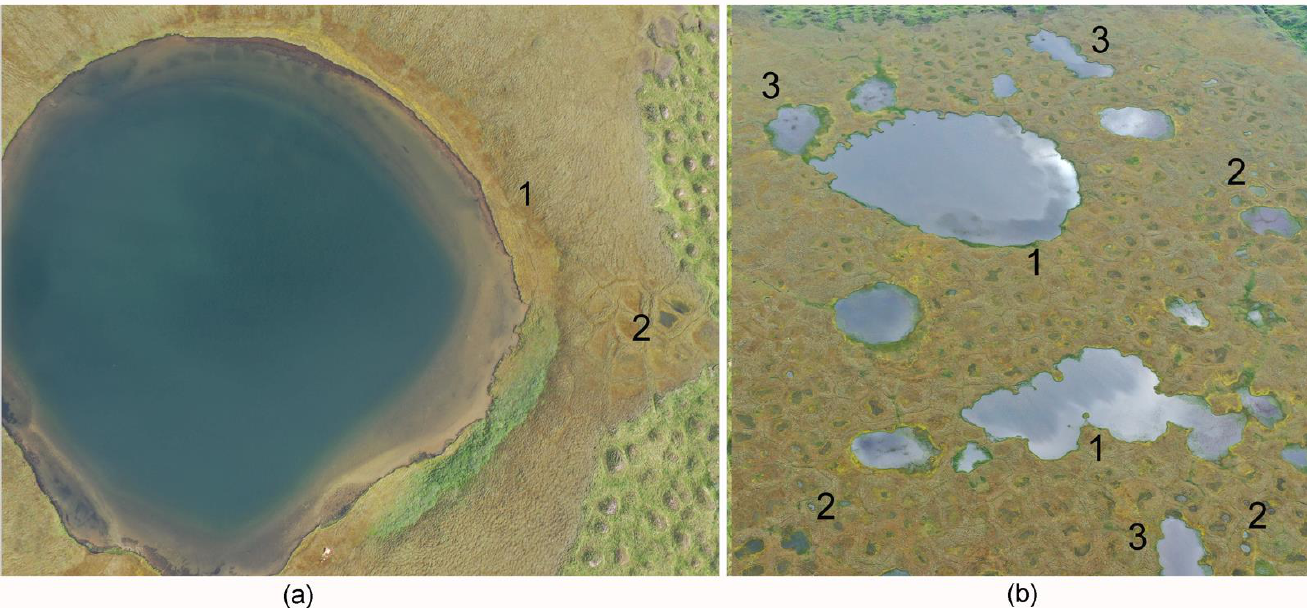
Figure 2. Main types of water bodies in Lena River Delta. Thermocarst lakes (1) located in allasse ( a ) and on flat tundra ( b ). Polygonal ponds: single (2) and complex